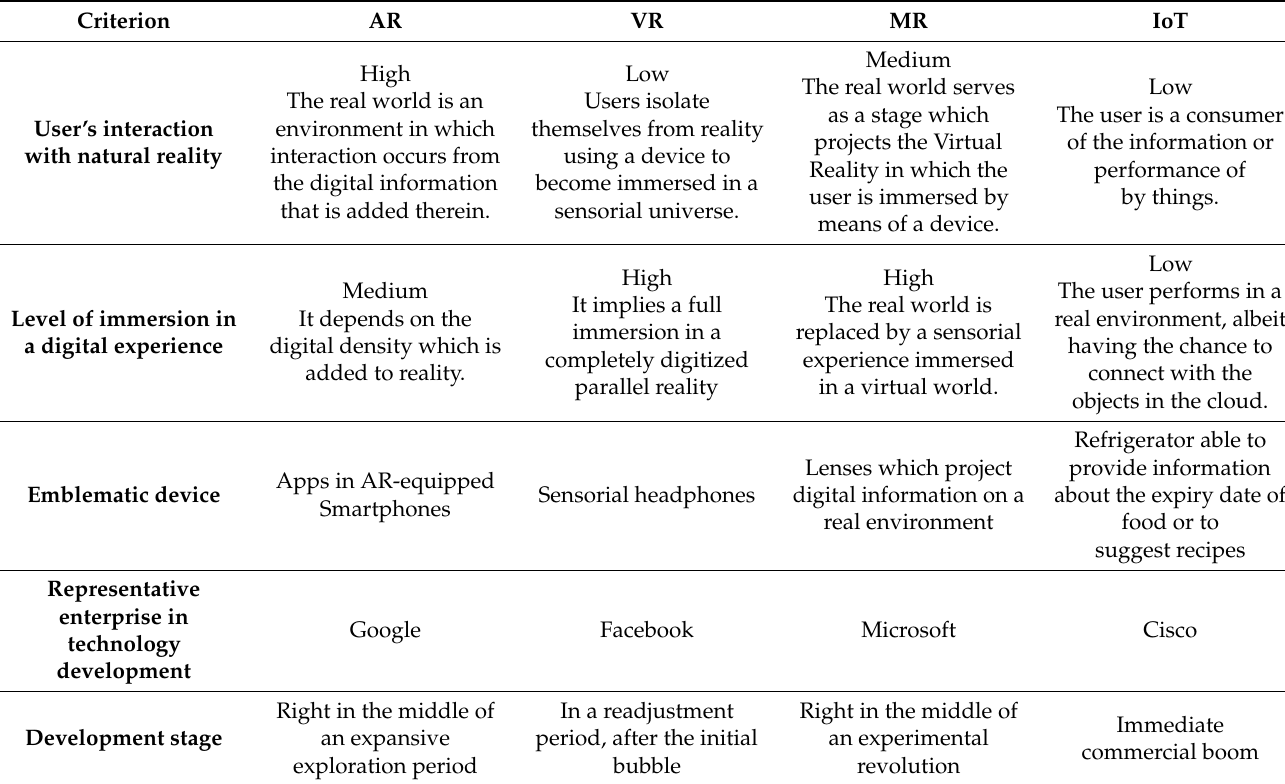
Table 1. Comparison between Augmented Reality (AR), Virtual Reality (VR), Mixed Reality (MR) and the Internet of Things